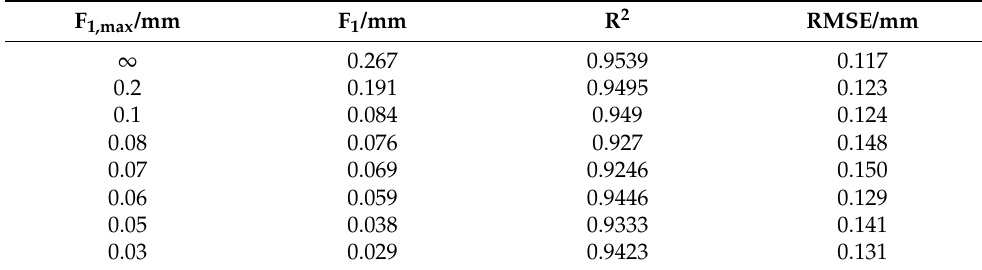
Table 8. Coefficient of determination and standard error in dependence of the maximum error effect for regression analysis of carburization depth.